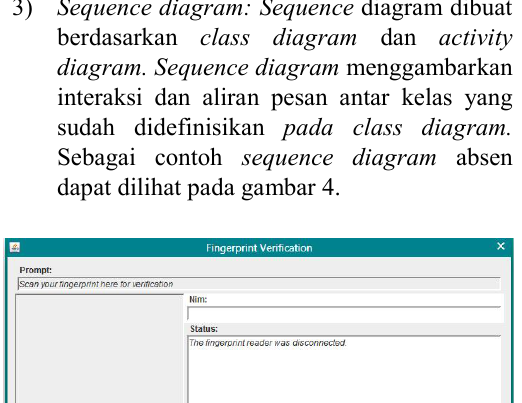
Gambar 4. Sequence diagram